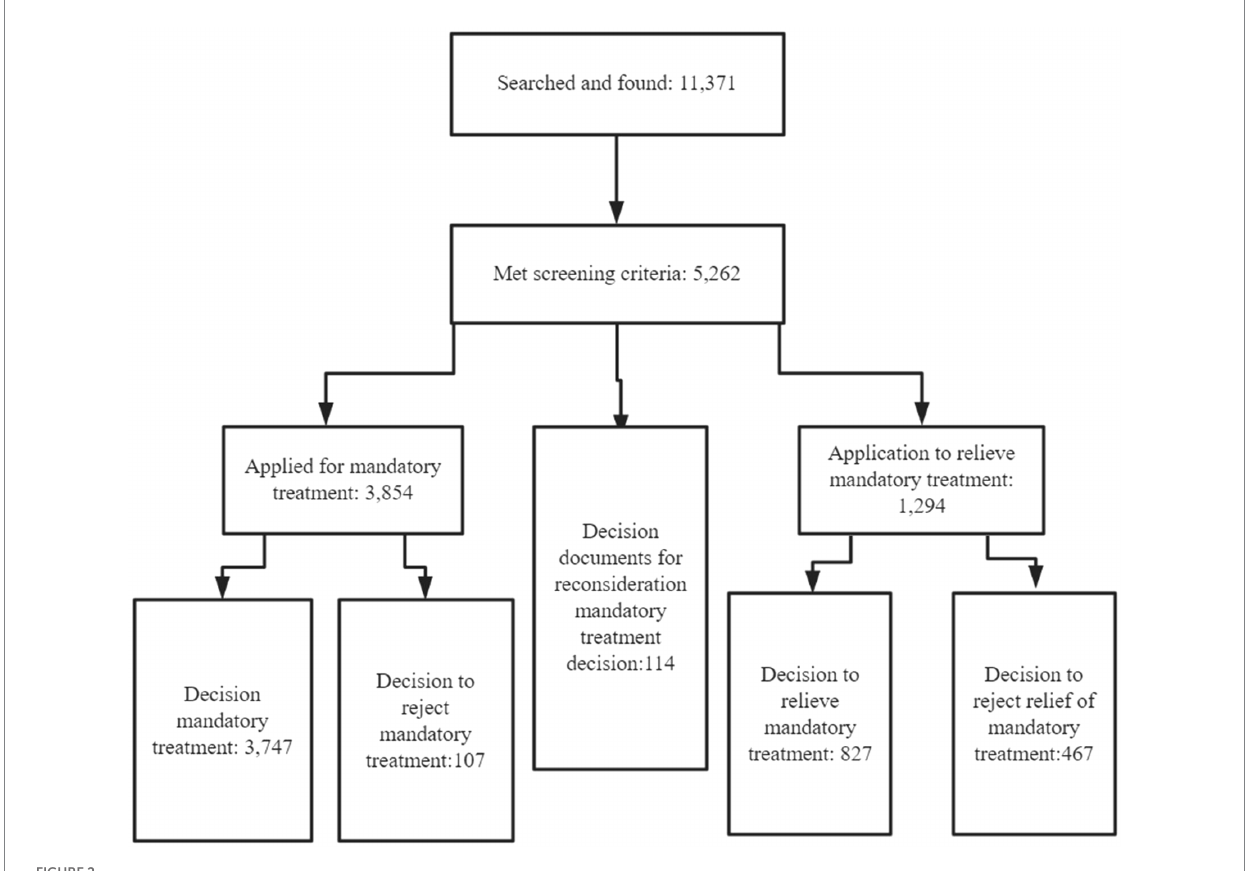
FIGURE 2 Flow chart of document